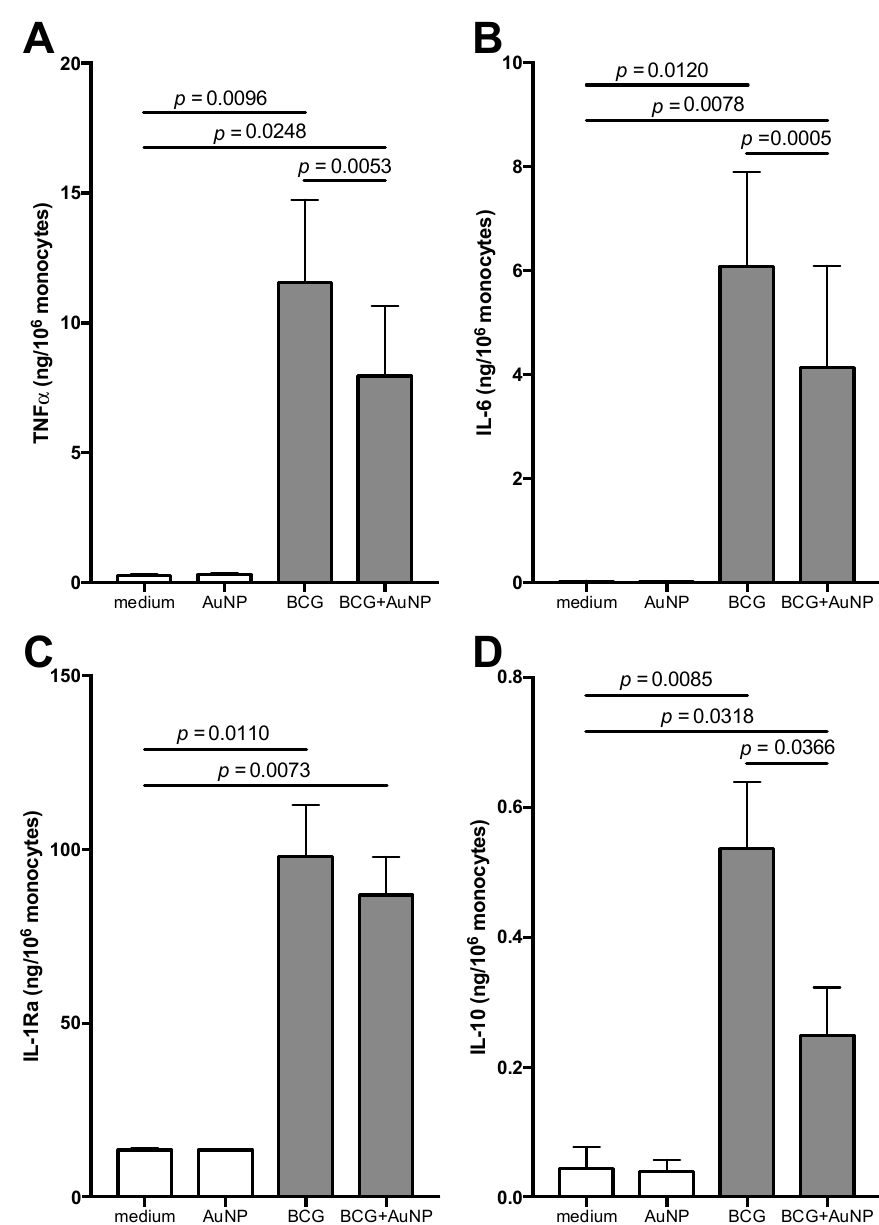
Figure 5. Primary response of human monocytes to BCG and AuNP. CD14 + monocytes were exposed for 24 h to BCG (MOI = 1) in the absence or in the presence of AuNP (10 μ g/mL). Release of TNF α ( A ), IL-6 ( B ), IL-1Ra ( C ) and IL-10 ( D ) was measured in the supernatants. Results are reported as mean ± SEM of data from 2–4 individual donors tested in separate experiments. p values are indicated when p < 0.05. Although statistically significant, we have not reported in the figure the differences between AuNP and BCG ( p = 0.0096 for TNF α , p = 0.0120 for IL-6, p = 0.0104 for IL-1Ra, and p = 0.0099 for IL-10) or between AuNP and BCG + AuNP ( p = 0.0249 for TNF α , p = 0.0078 for IL-6, p = 0.0067 for IL-1Ra, and p = 0.0498 for IL-10).